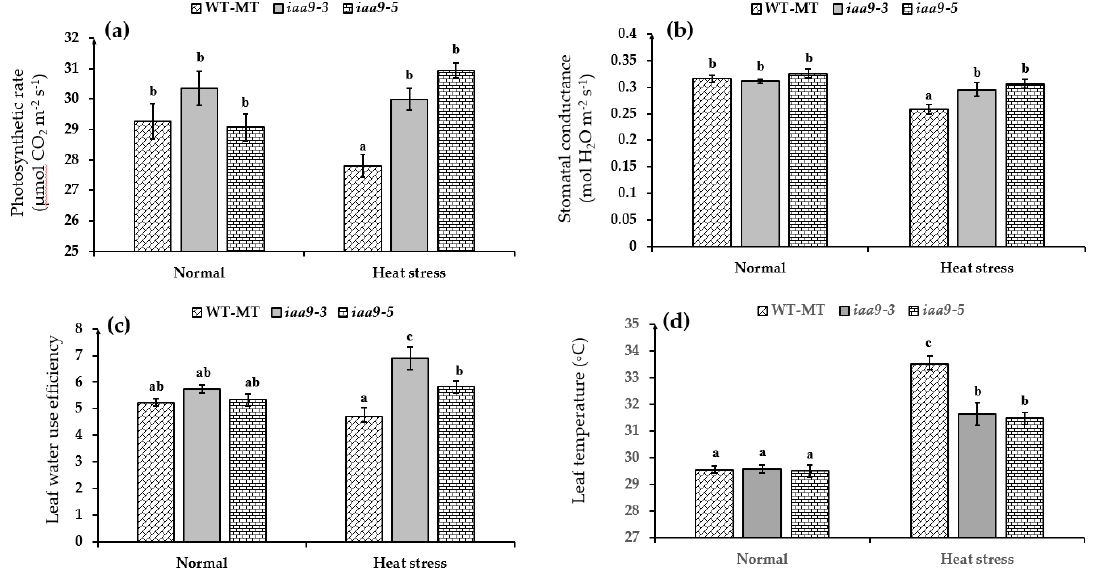
Figure 3. ( a ) Plant photosynthetic rate of WT-MT, iaa9-3 , and iaa9-5 under normal and heat